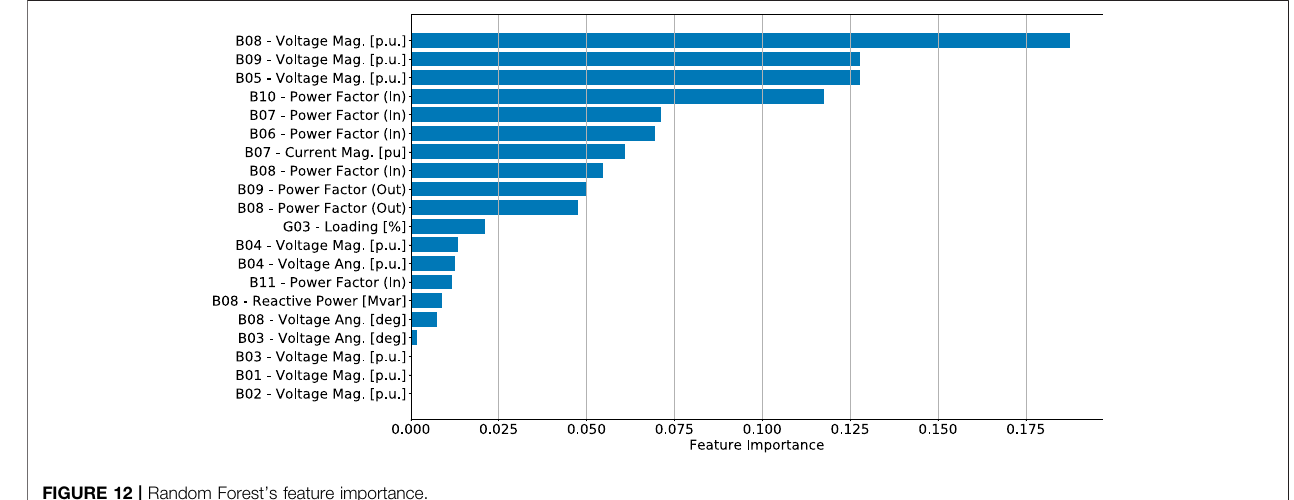
FIGURE 12 | Random Forest ’ s feature importance.